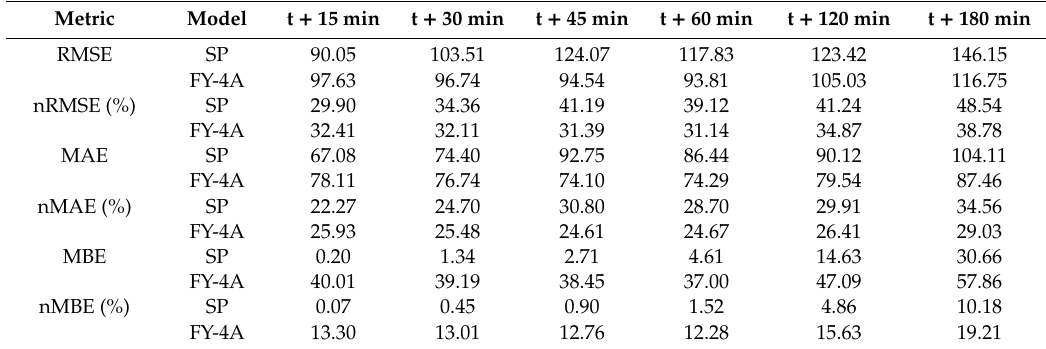
Figure 6. The forecasted results of GHI under overcast days with a 60 min horizon (01.11.2018, 09.11.2018, and 14.11.2018) for a total of 108 samples of the test set. Table 3. Statistical indexes for overcast skies with horizons from 15–180 min (in W / m 2 for the RMSE, MAE, and MBE).